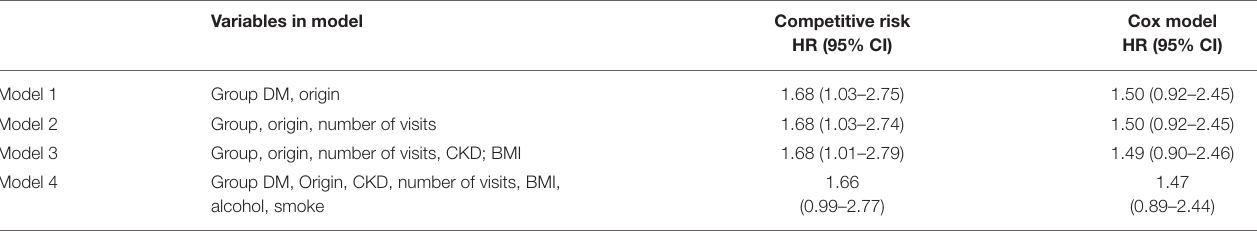
TABLE 3 | Estimated hazard ratios according to different